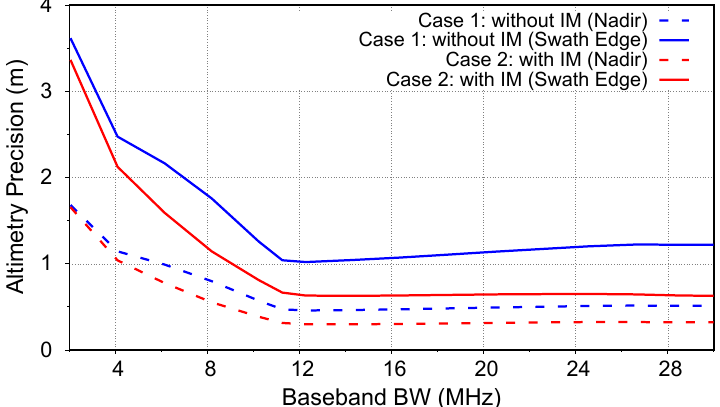
Figure 8. Altimetric precision at nadir and the edge of swath as a function of baseband bandwidth when considering the IM component. Case 1: without IM, Case 2: with IM. An incoherent average time of 1 s has been used in this